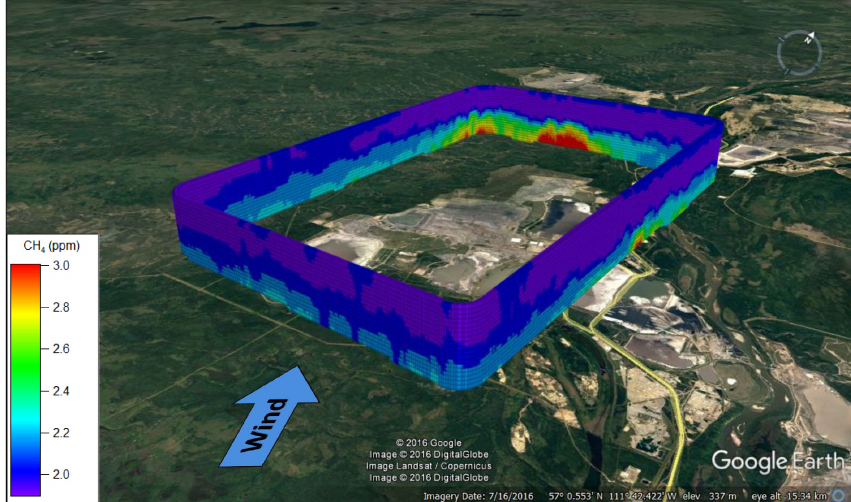
Figure 4. Interpolated CH 4 mixing ratios for the 14 August box flight surrounding SML.